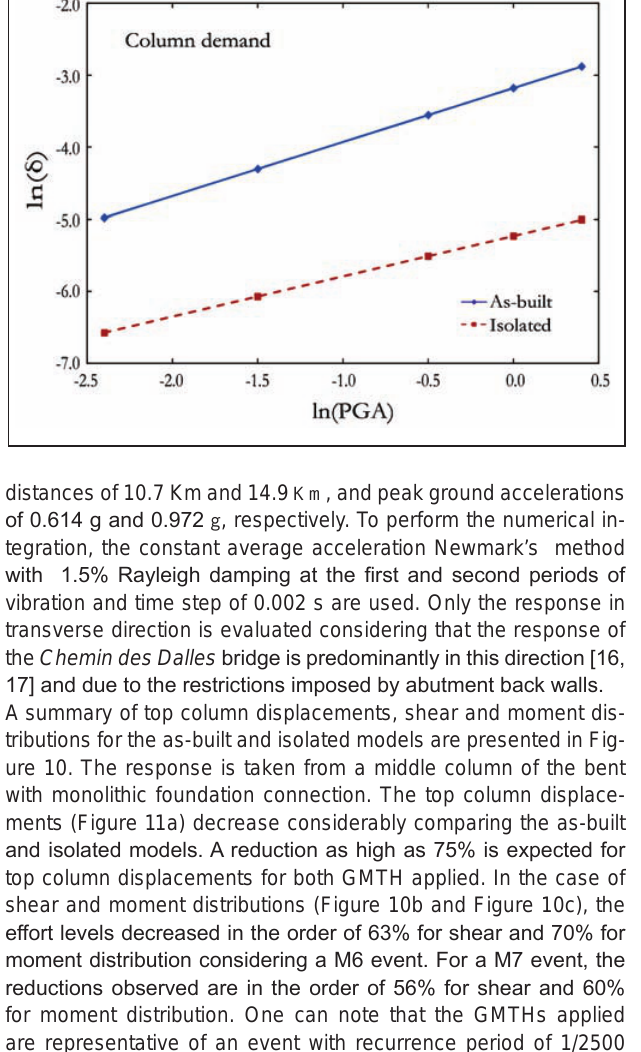
Figure 11 – PSDM comparison of median value of column displacement